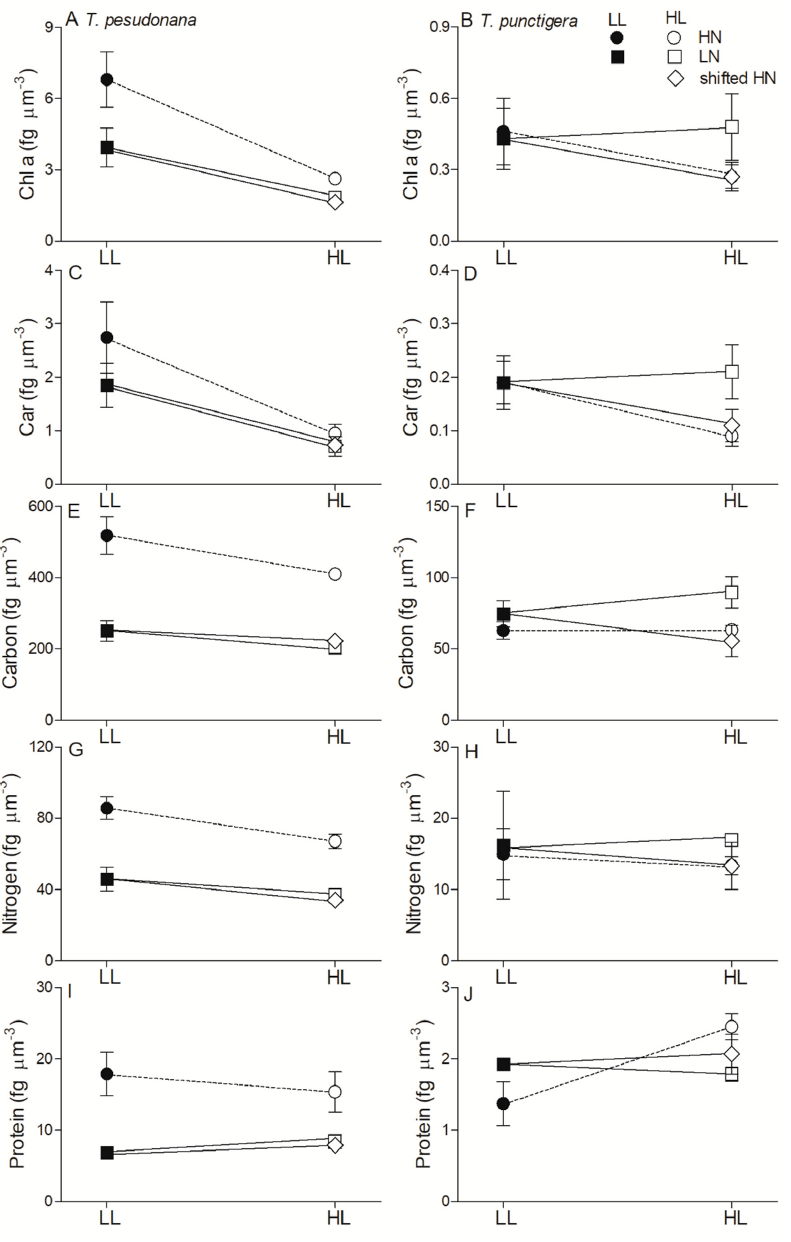
Figure 3. Cell biovolume-based contents (fg μ m − 3 ) of chlorophyll a ( A , B , Chl a ), carotenoids ( C , D , Car), carbon ( E , F , C), nitrogen ( G , H , N) and proteins ( I , J ) for small T. pseudonana ( A , C , E , G , I ) and large T. punctigera ( B , D , F , H , J ) grown under low and shifted-high lights, and under low and high/shifted-high nitrogen conditions. Points show averages of measurements on three independently grown cultures, and error bars show the standard deviations (n = 3), often within symbols.